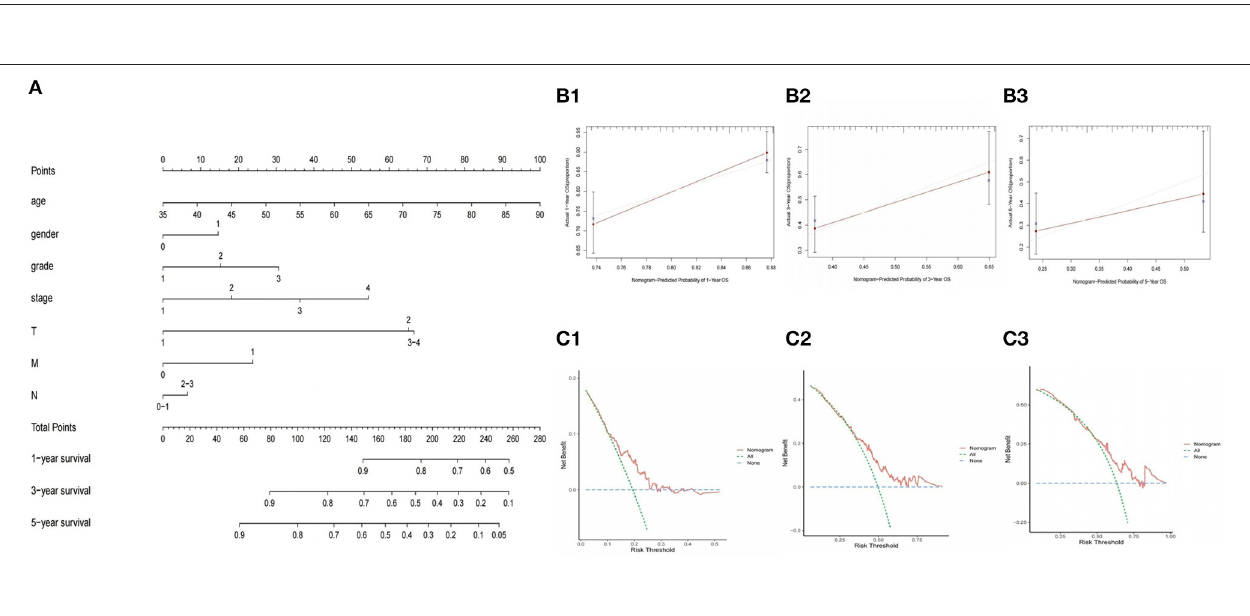
FIGURE 8 | Construction and validation of nomogram to predict the probability of 1-year, 3-year, and 5-year survival rate in GC. (A) Nomogram of prognostic model. (B1–B3) Verification of nomogram capability in the TCGA database. (C1–C3) Verification of DCA curves in the TCGA database.